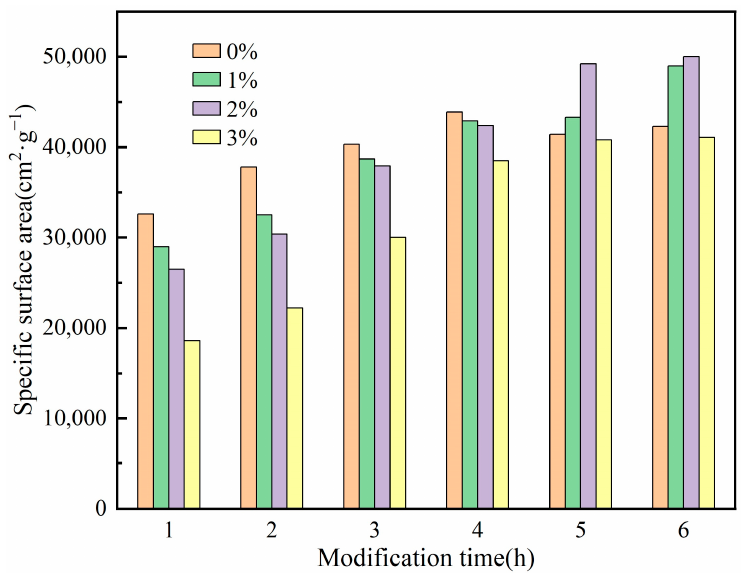
Figure 3. Variation of the speci fi c surface area of kaolin at di ff erent ball milling times.